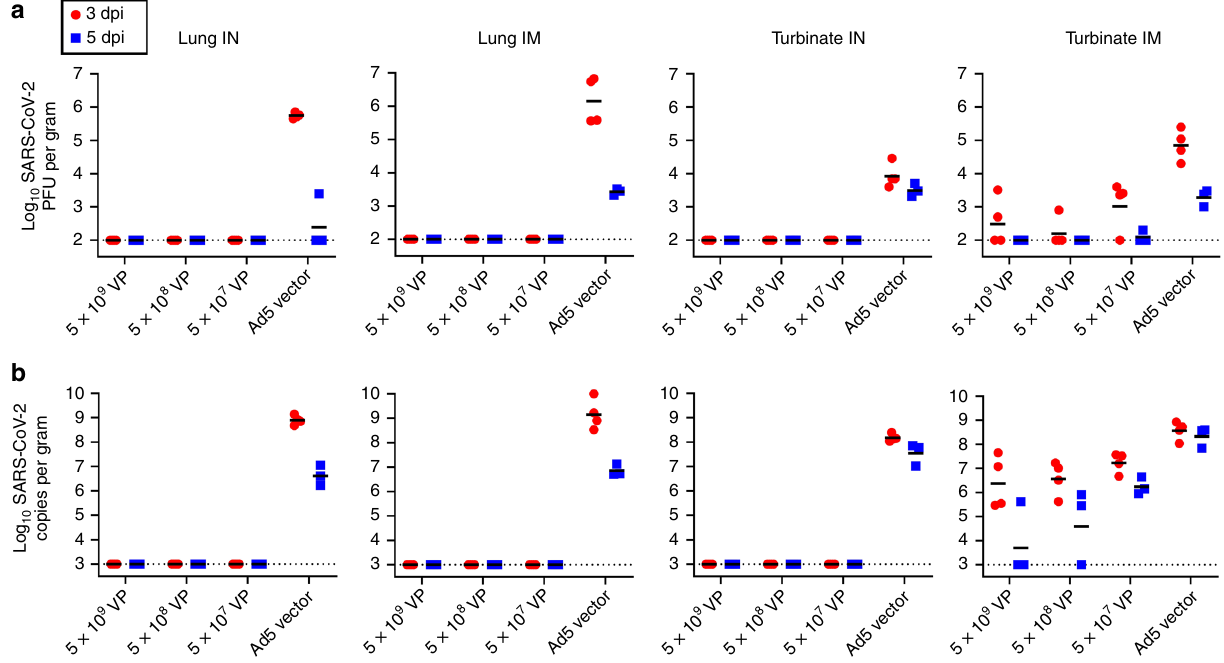
Fig. 2 Protective ef fi cacy of Ad5-nCoV in mice. BALB/c mice ( n = 10 biologically independent animals per group) received a single immunization with different doses of Ad5-nCoV or Ad5 vector by the IM or IN route, and seven of ten mice were challenged at week 10 with 10 3.6 PFU of mouse-adapted SARS-CoV-2 virus HRB26M in a volume of 50 μ L by the IN route. Tissue live virus numbers a and tissue viral loads b were detected at 3 dpi ( n = 4 biologically independent animals per group) and 5 dpi ( n = 3 biologically independent animals per group) in the lungs and turbinates, respectively.